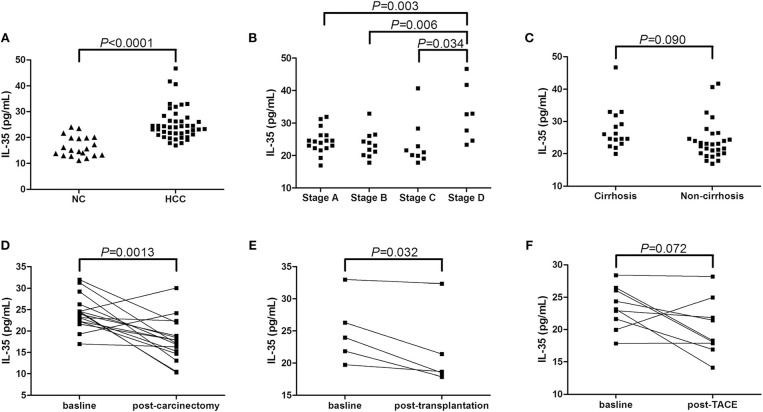
IL-35 expression in non-viral hepatitis-related hepatocellular carcinoma. (A) The concentration of IL-35 in the serum was measured by ELISA in healthy individuals (n = 20) and non-viral hepatitis-related HCC (n = 44). The individual level for each subject was shown. Significance was assessed using Student t-test. (B) Serum IL-35 level was compared among HCC patients in BCLC stage A (n = 17), stage B (n = 11), stage C (n = 9), and stage D (n = 7). Significances were assessed using SNK-q test. (C) Serum IL-35 was also compared between patients with cirrhosis (n = 16) and without cirrhosis (n = 28). Significance was assessed using Student t-test. (D) IL-35 expression in the serum was measured in patients underwent hepatic carcinectomy (n = 16). Significance between baseline and post-carcinectomy was assessed using paired t-test. (E) Serum IL-35 expression was measured in patients underwent liver transplantation (n = 5). Significance between baseline and post-transplantation was assessed using paired t-test. (F) Serum IL-35 level was also measured in patients underwent TACE (n = 9). Significance between baseline and post-operation was assessed using paired t-test.